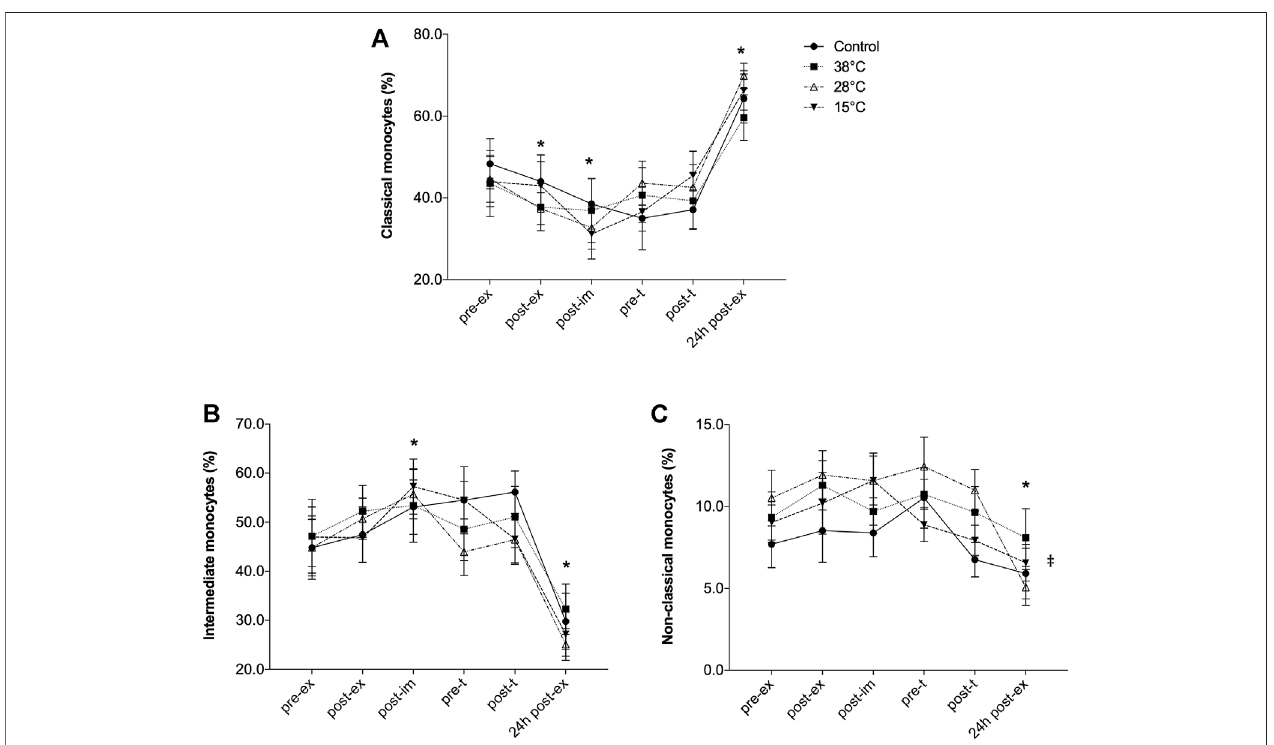
FIGURE 4 | Effect of exercise recovery by water immersion on the percentage of blood monocyte subsets. Classical monocytes (A) , Intermediate monocytes (B) and Non-classical monocytes (C) .* p < 0.05, main time effect, compared to pre-ex, mixed-effects analysis, followed by Dunnett ’ s multiple comparison test. p < 0.05, maintreatment effect,28 ° Cand 38 ° Cversuscontrol,repeated two-way ANOVA, followed byDunnett ’ smultiplecomparison test. Pre-ex – beforeexercisesession,post- ex – immediately after exercise session, post-im – immediately post immersion, pre-t – immediately before performance tests, post-t – immediately post performance tests, 24 h post-ex – 24 h after the exercise